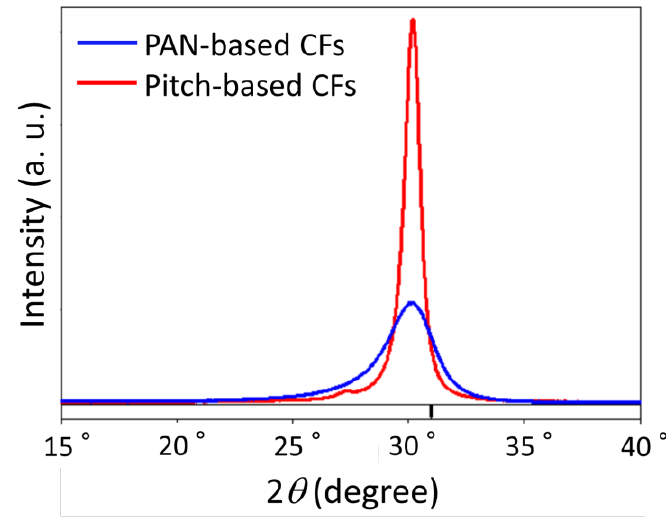
Figure 4. XRD patterns of PAN- and pitch-based CFs. The bar denotes the XRD peak position of the (002) plane of the graphite in a previous study [23].